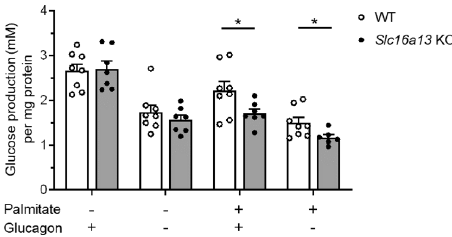
Fig. 10 Gluconeogenesis in Slc16a13 knockout primary hepatocytes. Glucose production of primary hepatocytes isolated from Slc16a13 WT ( n = 8) and Slc16a13 KO ( n = 7) mice at a mean age of 20 weeks. Hepatocytes were stimulated with 500 µ M BSA-coupled palmitate (6:1 molar ratio) or BSA control and 100 nM glucagon or vehicle control as indicated. Cell culture supernatant was collected after 8 h of incubation in glucose-free media containing 20 mM lactate and 2 mM pyruvate. Bars represent